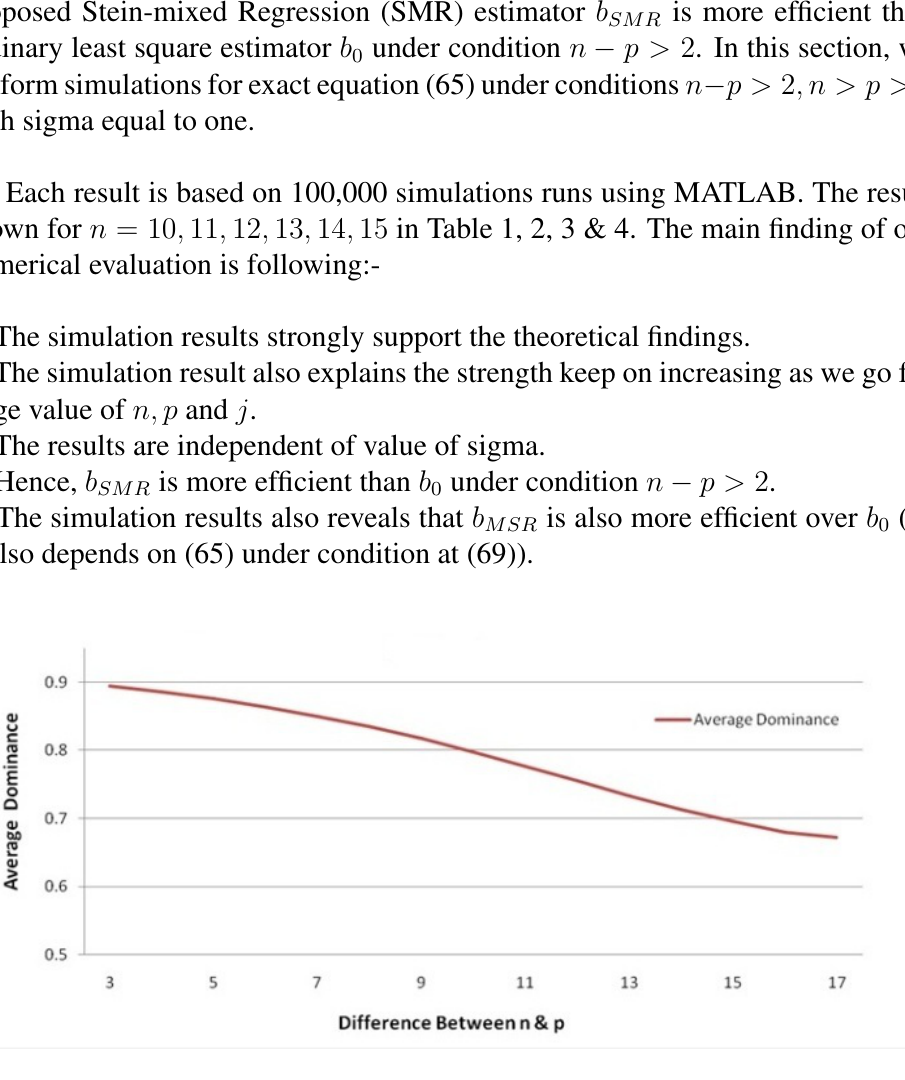
Figure 1: Average dominance condition for difference between n &